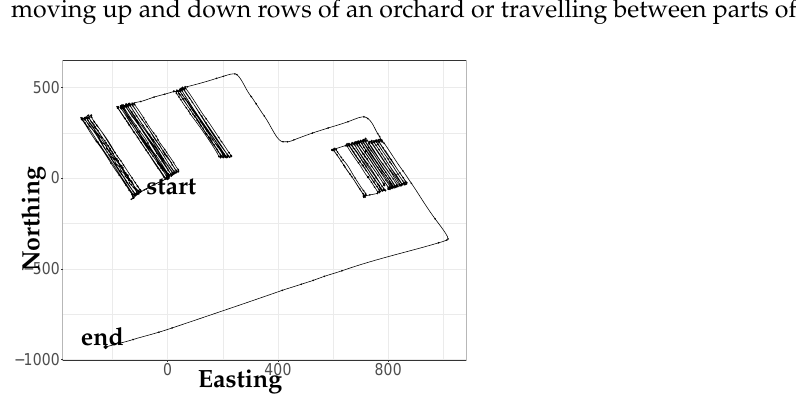
Figure 3. Reconstruction of the complete real GPS data set; “start” and “end” indicate the start and end points of the